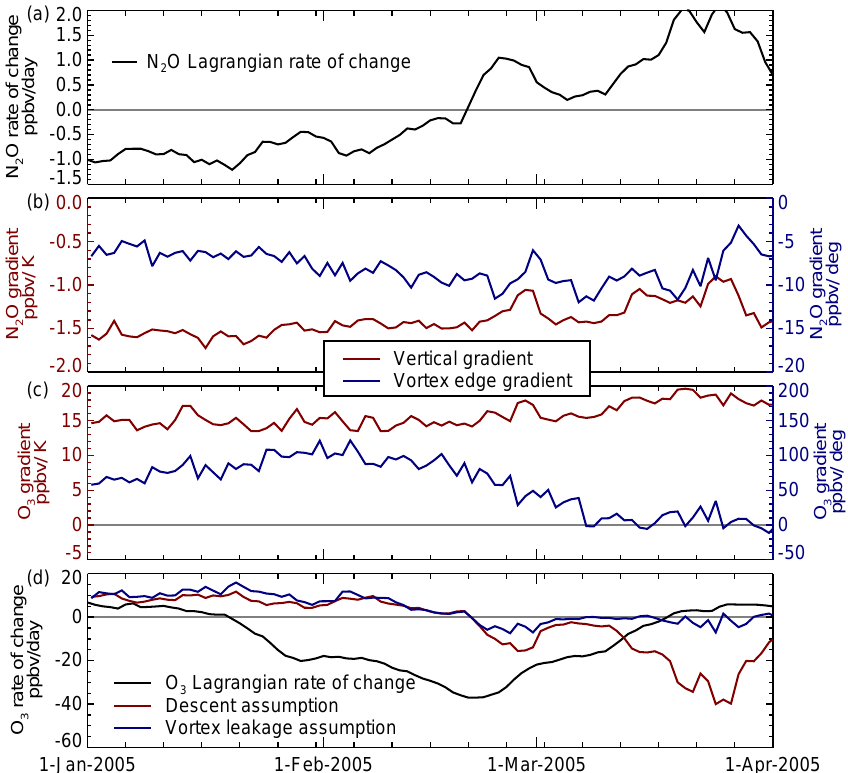
Figure 4. (a) Estimated 450K N 2 O Lagrangian rate of change. (b) 450K vortex-average N 2 O vertical gradients (red lines, left hand axes) and N 2 O gradients with respect to equivalent latitude at the vortex edge (blue lines, right hand axes). (c) as (b) but for O 3 . (d) Reported 450K O 3 Lagrangian rate of change (i.e., estimated creation or loss rate, black line), and potential contributions to O 3 rate of change from transport errors estimated via the descent (red line) or mixing (blue line)